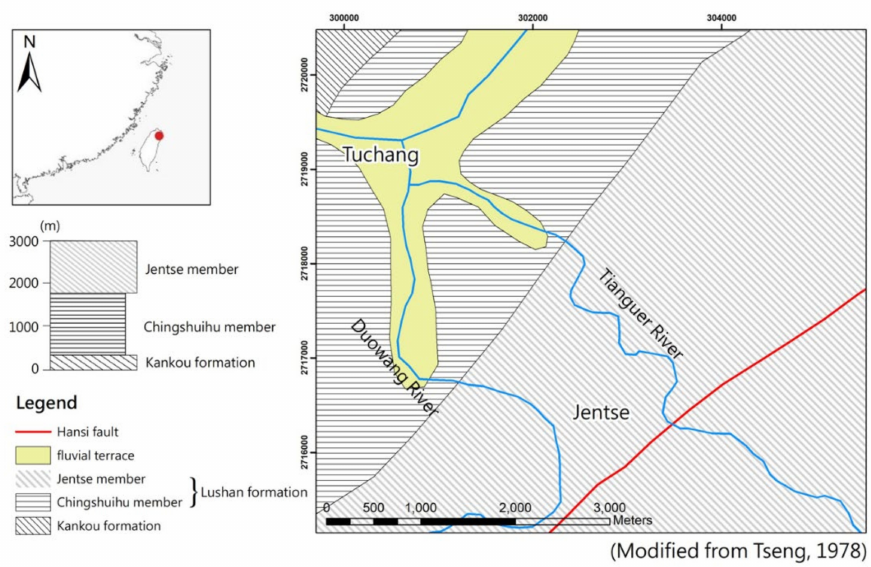
Figure 2. The geology of the study area. Sampling sites in the Tuchen geothermal field. The stratigraphic unit exposed in the geothermal prospects of the northern Central Range is the Miocene Lushan Formation, which is mainly composed of slate. The Lushan Formation can be seen in two members, the Chinshuihu Member and the Jentse Member, based on lithological differences in the study area, Tianguer and Duowang river watersheds. (Modified from Tseng,